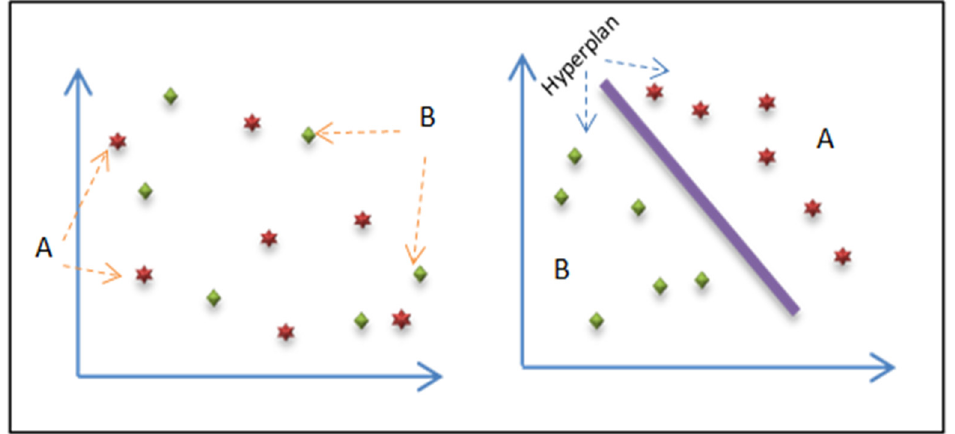
Figure 3. The SVM linear solution with the decision boundary.